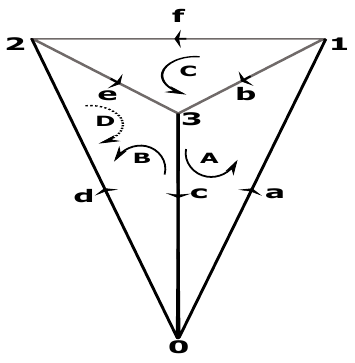
Figure 12. S 2 is homeomorphic to tetrahedron.